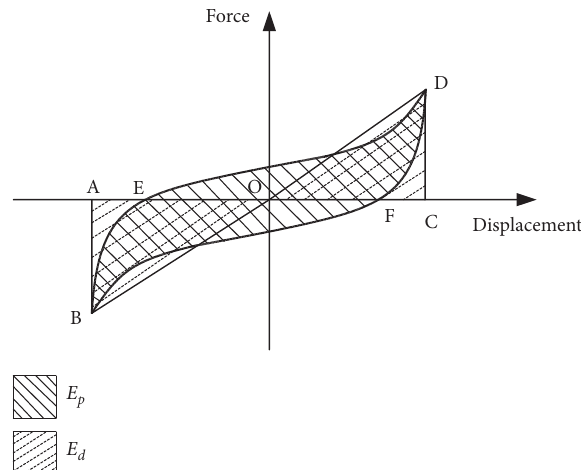
Figure 21: Determination of energy